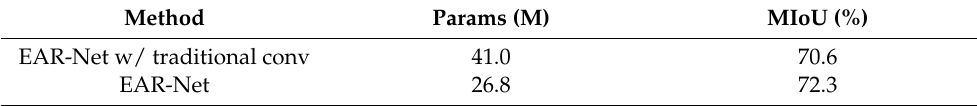
Table 4. The ablation study for DSConv analysis on the Cityscapes validation set. Method Params (M) MIoU (%) EAR-Net w/ traditional conv 41.0 70.6 EAR-Net 26.8